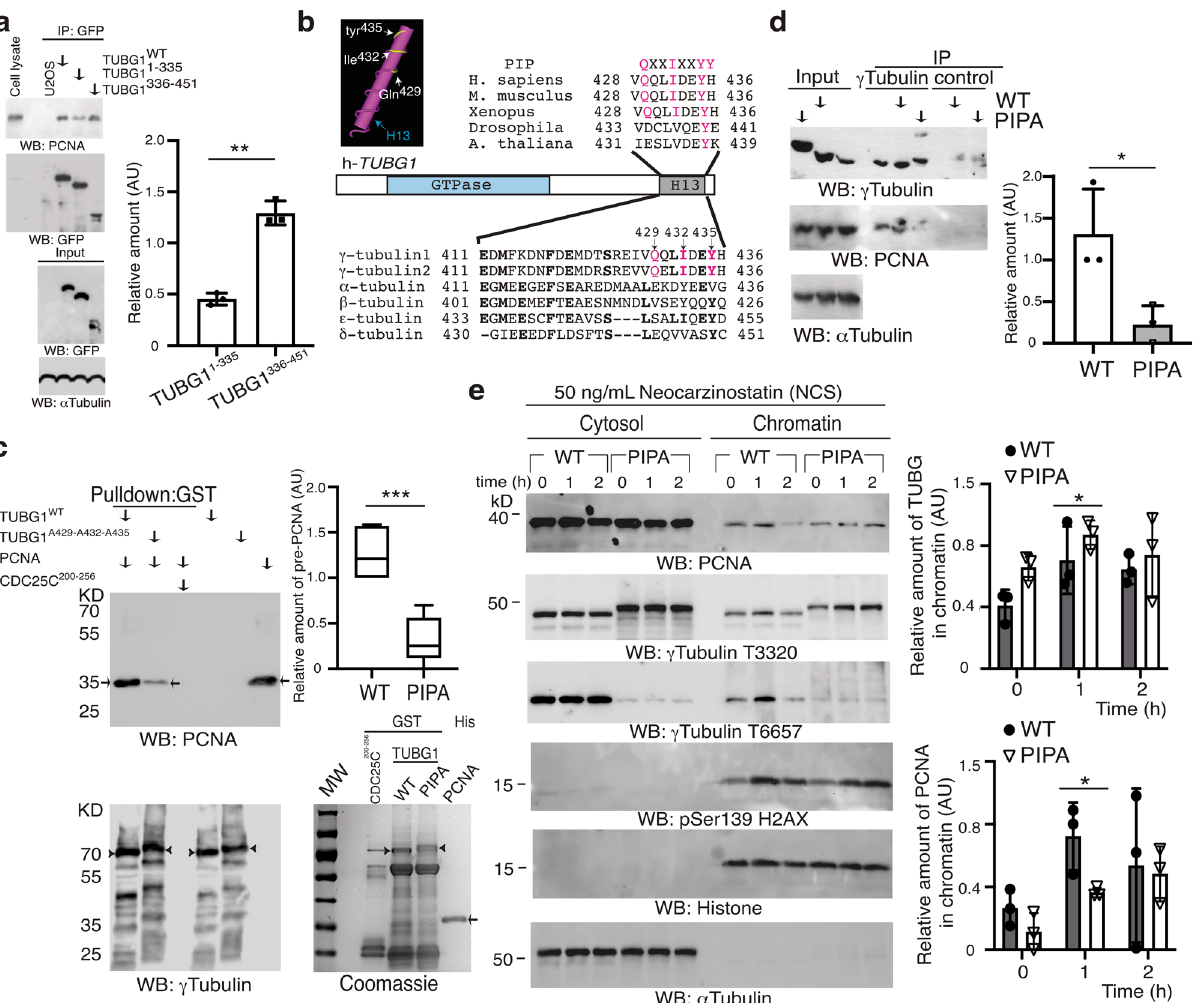
Fig. 6 The γ -tubulin C terminus interacts with PCNA. a Extracts from U2OS cells, or such cells stably coexpressing TUBG -shRNA and GFP- γ -tubulin, GFP- N- γ -tubulin 1 – 335 , or GFP-C- γ -tubulin 336 – 451 were used, and GFP was immunoprecipitated with an anti-GFP antibody and developed by WB with the indicated antibodies ( N = 3). b Sequence alignment of the C-terminal α -helix (H13) region of human γ -tubulin 1 and γ -tubulin 2 and α -, β -, ε -, and δ -tubulin. Bold letters indicate identical residues. Magenta letters represent residues included in the PIP. The known 3D structure of the C-terminal H13 region of human γ -tubulin revealed with the 3D structure viewer Cn3D. Important amino acids are highlighted in white. c Puri fi ed His-PCNA (arrows) was incubated with one of the following glutathione Sepharose af fi nity resin-bound GST-tagged proteins (arrowheads): γ -tubulin (TUBG1 WT ; WT), γ -tubulin A429-A432- A435 (TUBG1 A429-A432-A435 ; PIPA), or CDC25C 200 – 256 . Thereafter, the bound His-PCNA was examined by WB and the mean value of the PCNA signal (determined as its ratio with WT or PIPA) is represented in the graph (mean± SD; N = 5, *** P < 0.001). Total amounts of loaded proteins were analyzed by WB and Coomassie staining. d Extracts from U2OS cells or U2OS cells co-expressing stably TUBG1 -sgRNA and either γ -tubulin resist (WT) or a γ - tubulin A429-A432-A435 resist (PIPA) were used, and γ -tubulin was immunoprecipitated with an anti- γ -tubulin antibody and developed by WB with the indicated antibodies ( N = 3). a , d One-tenth of the total lysates used for immunoprecipitation was analyzed by WB (Input). The graphs illustrate densitometric analysis of the PCNA content in the indicated protein immunoprecipitates in the presented WBs. To adjust for differences in protein loading, the concentration of a protein was determined as its ratio with the immunoprecipitated protein ( N = 3). e Extracts from neocarzinostatin-treated U2OSsg TUBG1 - TUBG1 WT (WT) and U2OSsg TUBG1 - TUBG1 A429-A432-A435 (PIPA) cells were prepared as in Fig. 2b and examined by WB using the indicated antibodies against PCNA, γ -tubulin, phospho-histone2AX, α -tubulin, and histone. The two graphs illustrate the mean values of the γ -tubulin and the PCNA signal in chromatin. To adjust for differences in protein loading, the concentration of a protein was determined as its ratio with histone for each time point (mean ± SD; N = 3, * P < 0.05). a , c – e Source data are provided in Supplementary Data 1. See also Supplementary Fig.